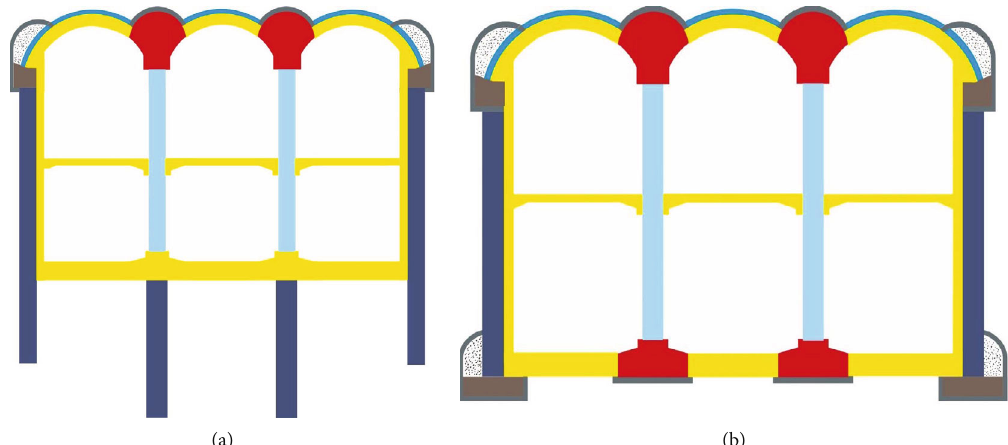
Figure 1: Standard cross section of the underground excavation station obtained by PBA approach: (a) pile foundation station and (b) strip foundation (Table 1 (f)); and the stage of platform layer soil excava- tion and fl oor construction (Table 1 (g)).